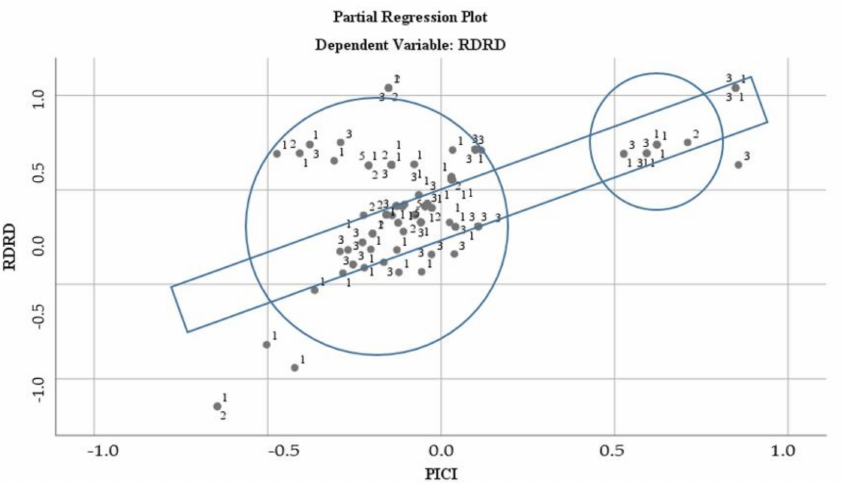
Figure 10. Regression analysis for PICI.